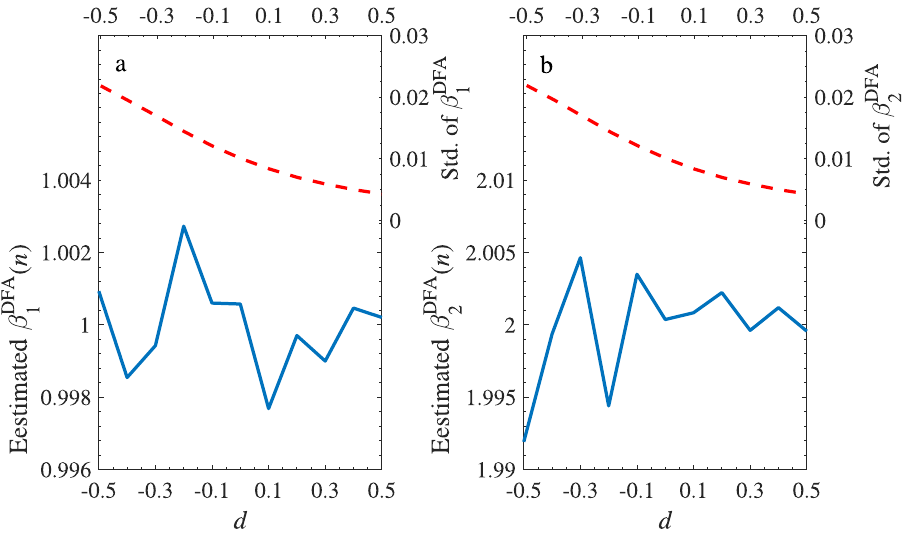
Figure 1. Estimated two DFA Regression coefficients with setting I of ARFIMA model. Mean values of the DFA estimators and standard deviation are shown as solid line (left axis) and dashed line (right axis), respectively. X 1 and X 2 are two independent variables generated by ARFIMA model with the same changing fractional integration parameter ( x -axis) and independent Gaussian noise. Y = 1 + X 1 + 2 X 2 + ε , ε is a standard Gaussian noise error-term. Both of them are of length 10000 and repeated 1000 times. ( a ) is the result for the estimated DFA β ˆ DFA and ( b ) is for the estimated β ˆ . The DFA estimators β 1 and β 2 are unbiased at 1 and 2 with the error- 1 2 term ± 0.002 and ± 0.005, respectively, and their standard deviations decrease with the memory strength.